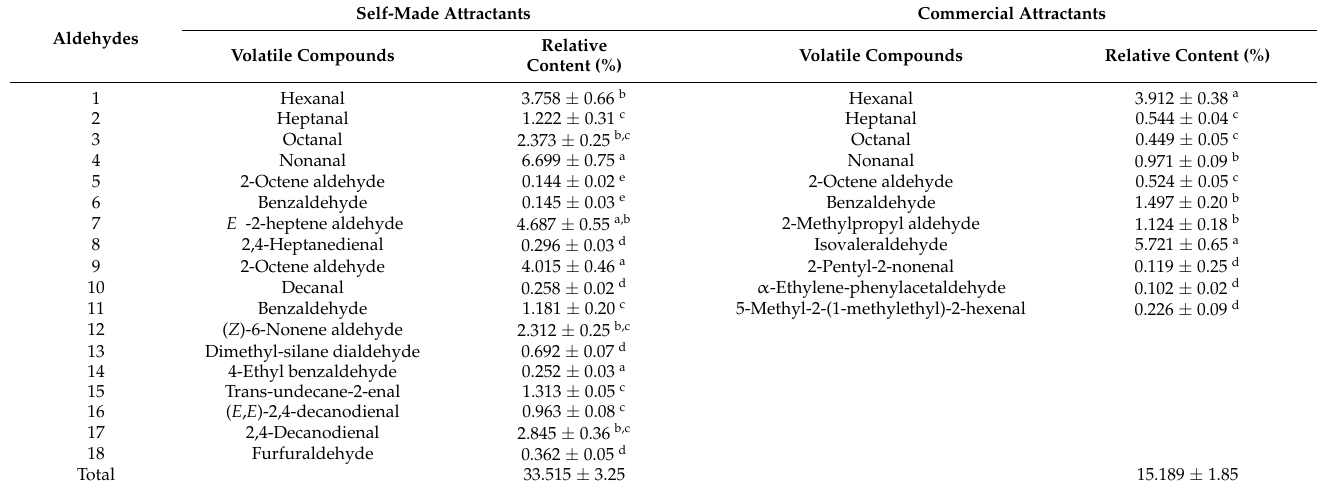
Table 4. Aldehydes in self-made and commercial attractants (percentage of the total peak